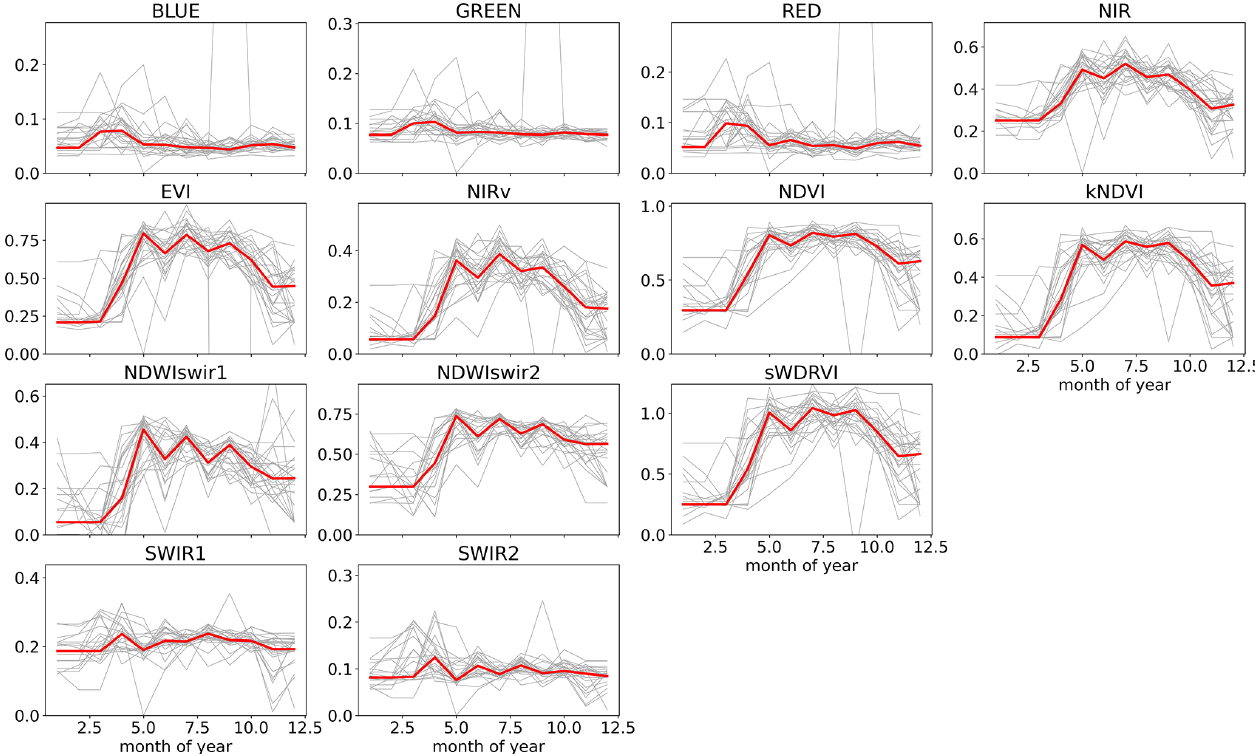
Figure 3. Median seasonal cycle (red) and individual yearly trajectories (grey) of the different data sets in the 30m pixel containing the Austrian site Neustift (AT-Neu)